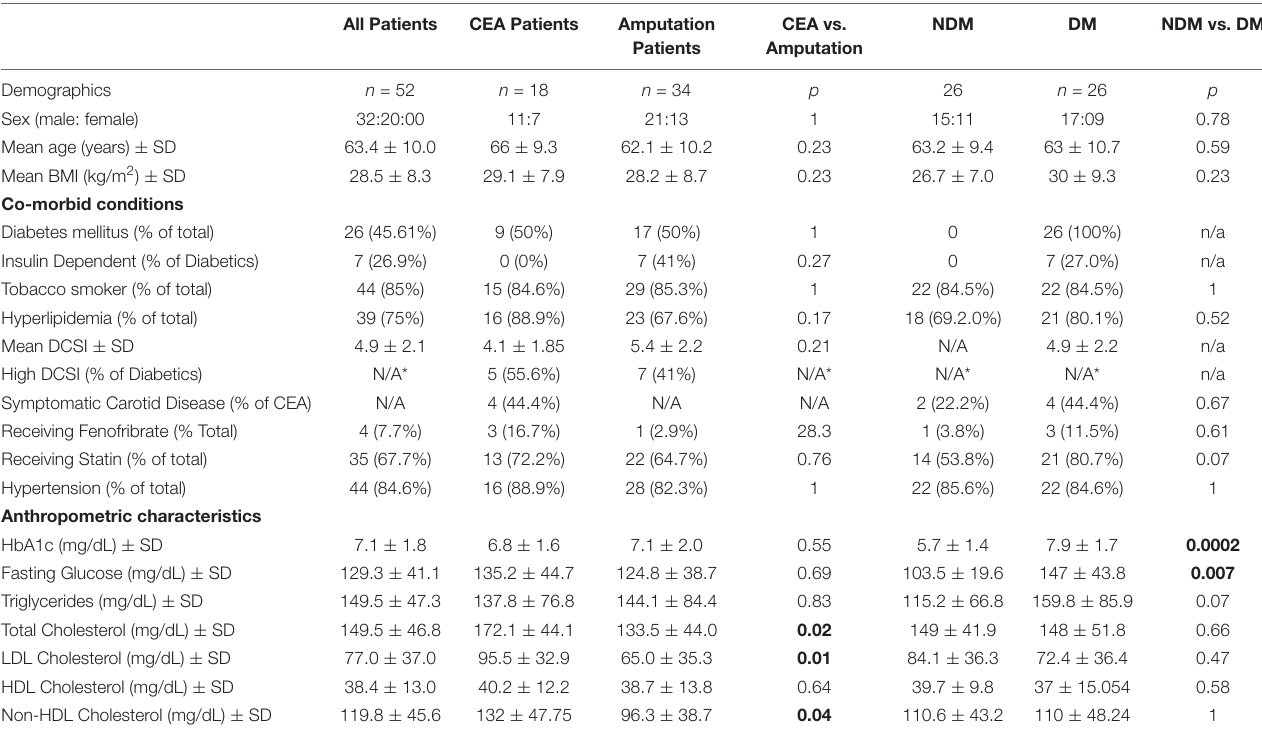
TABLE 1 | Patient clinical